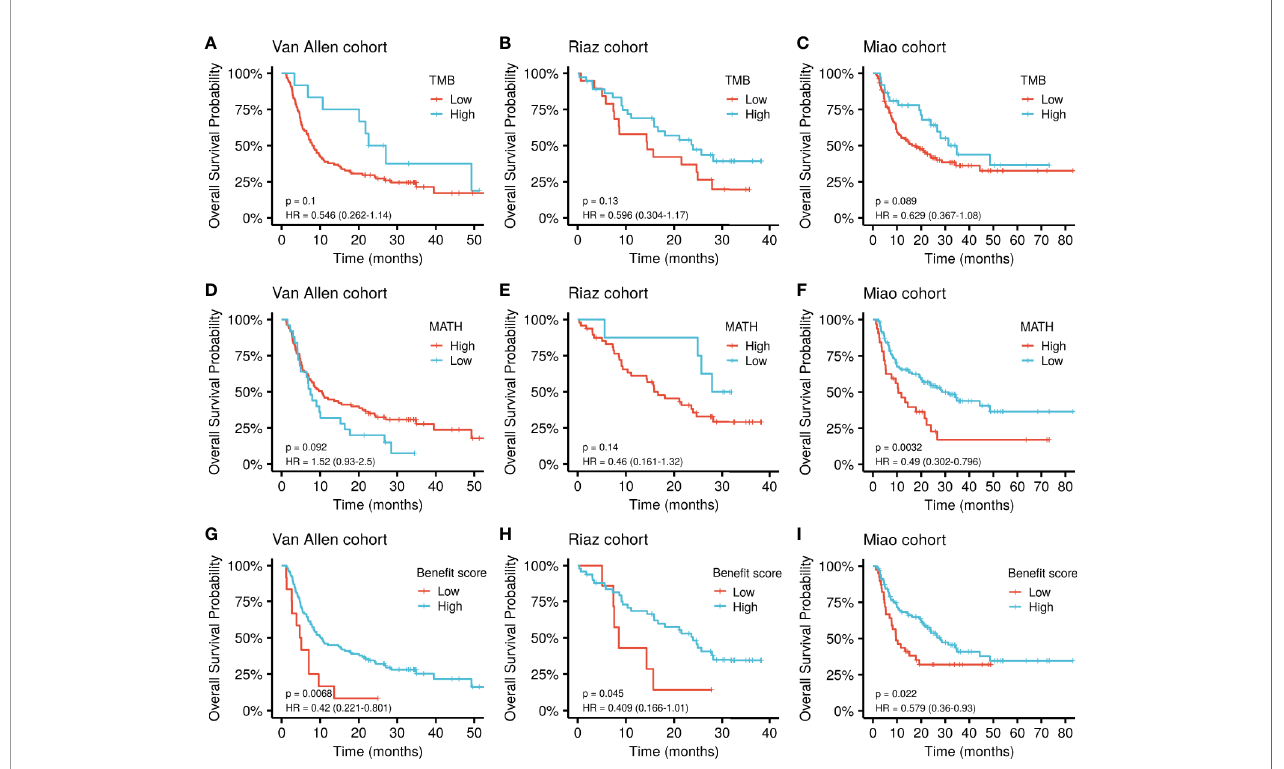
FIGURE 3 | Kaplan-Meier curve of overall survival by TMB, MATH, and bene fi t scores in different datasets. (A – C) Survival curves for the TMB in each cohort. (D – F ) Survival curves for MATH in each cohort. (G – I) Survival curves for the bene fi t score in each cohort. P values of the log-rank test are shown at the top right for each